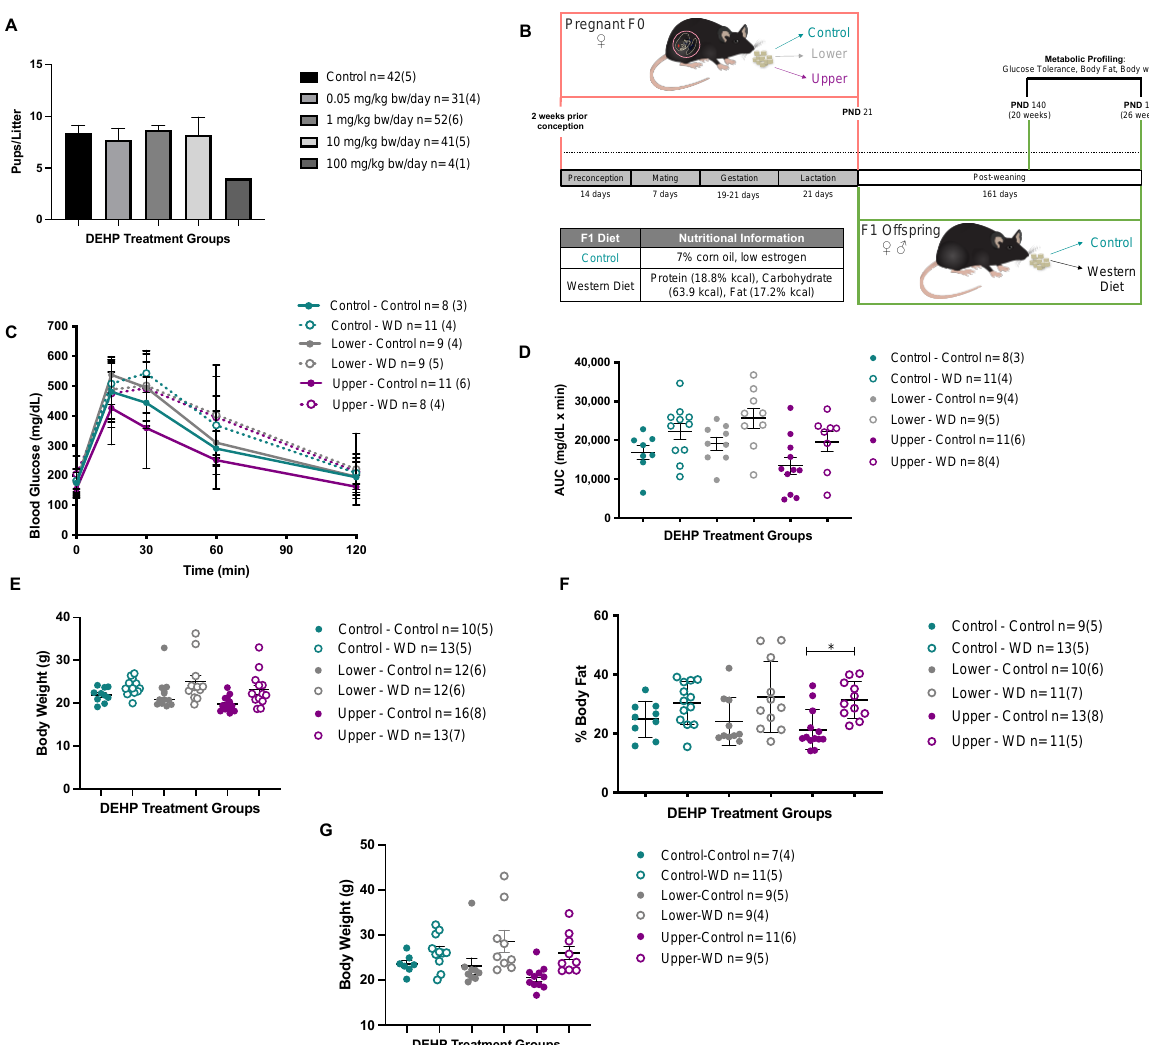
Figure 2. (Di-2-ethyhexyl-phthalate (DEHP) dose-response and F1 female adult offspring metabolic phenotyping profile. ( A ) Dose-response relationship between DEHP exposure in utero and E17.5 embryos per litter. ( B ) DEHP F0 exposure paradigm where F0 females were exposed to two DEHP doses (Lower: 50 ug/kg/day, Upper: 10 mg/kg/day) starting 2 weeks prior to conception until weaning. After weaning F1 offspring was placed on either a control or a Wester Diet challenge until PND182. At PND140: ( C ) Glucose tolerance test, ( D ) Glucose Area Under the Curve (AUC, mg/dL × min), and ( E ) Body weight. At PND182: ( F ) Body composition by DEXA scan and ( G ) Body weight. N = # of individuals (# of litters), * p < 0.05.